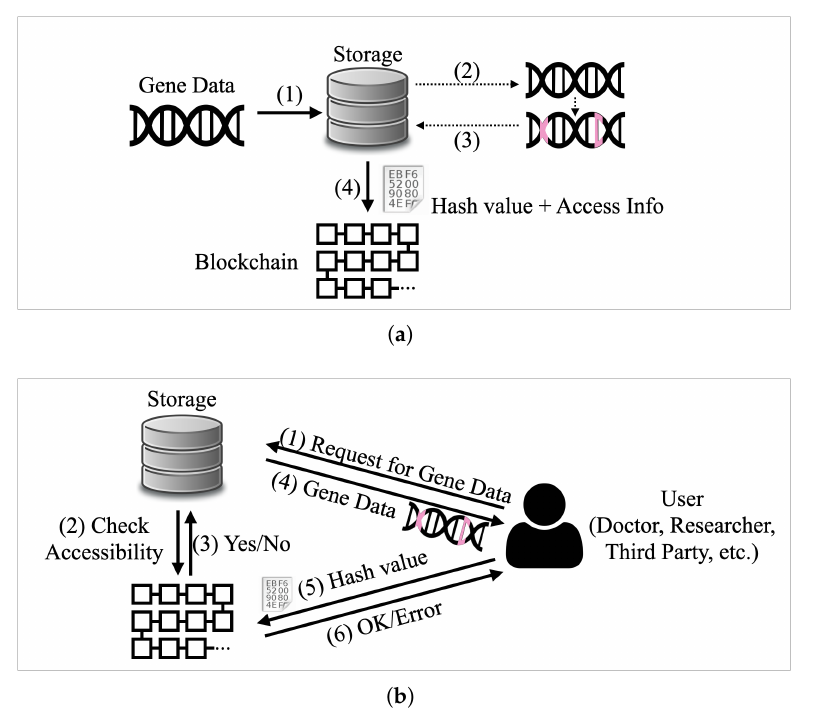
Figure 2. Interactions between storage and blockchain. ( a ) Saving of gene data; ( b ) Retrieval of gene